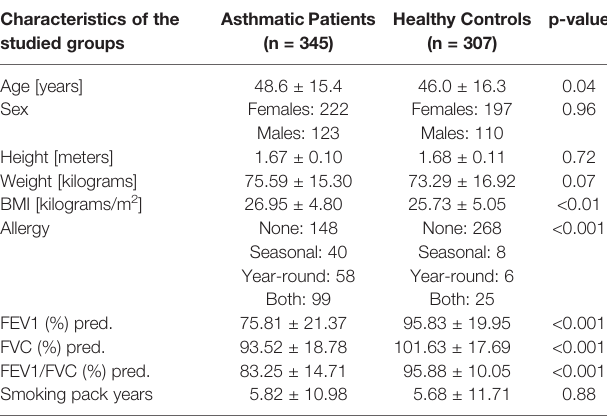
TABLE 2 | Clinical characteristics of the recruited cohort and presentation of spirometric characteristics of studied groups. Characteristics of the studied